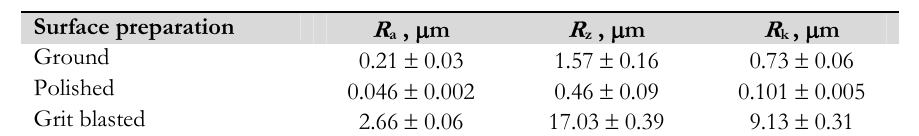
Table 1: Parameters describing the surface profile of the substrates as a function of surface preparation method [55]. Values are the average of three measurements, with standard error of the mean indicated.